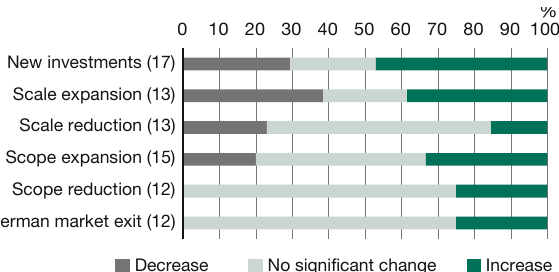
Expectations about development in Chinese investors’ enquiries by investment purposes, fi rst half of 2021 Share of fi rms and